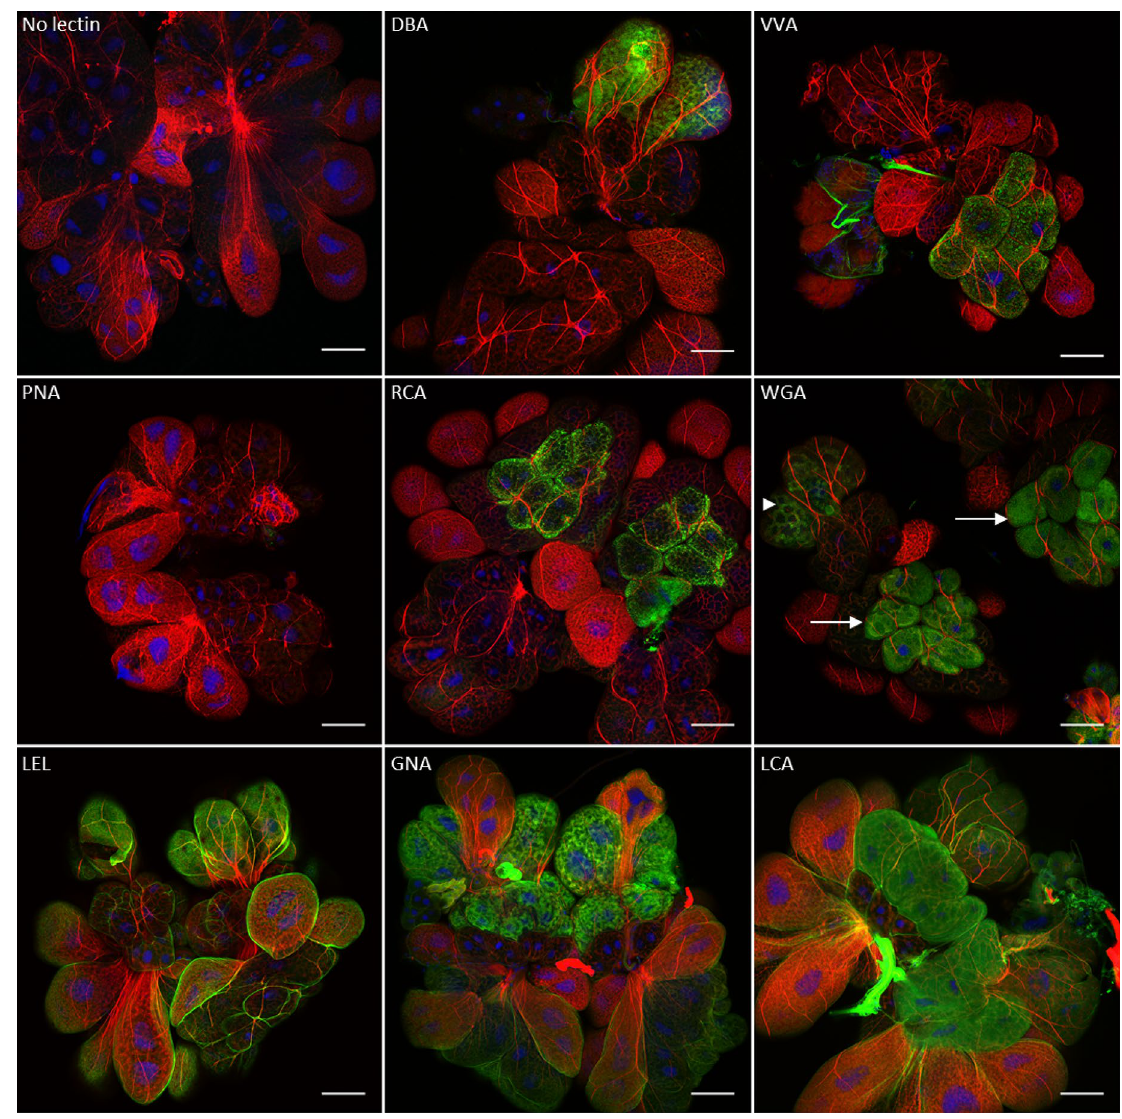
Figure 2. Observation of fluorescent lectins binding salivary gland cell carbohydrates of E . variegatus by laser scanning microscopy. Cell nuclei were stained with DAPI (blue), and actin filaments were stained with Alexa 568-phalloidin (red). The FITC-lectins were colored in green. The fluorescent lectins used to stain the cells are indicated in each picture except for the control, where fluorescent lectin was omitted. The arrowhead indicates one of the two cell types that possess glycoconjugates bound by the WGA lectin, and the arrows indicate the other cell type. Scale bar 100